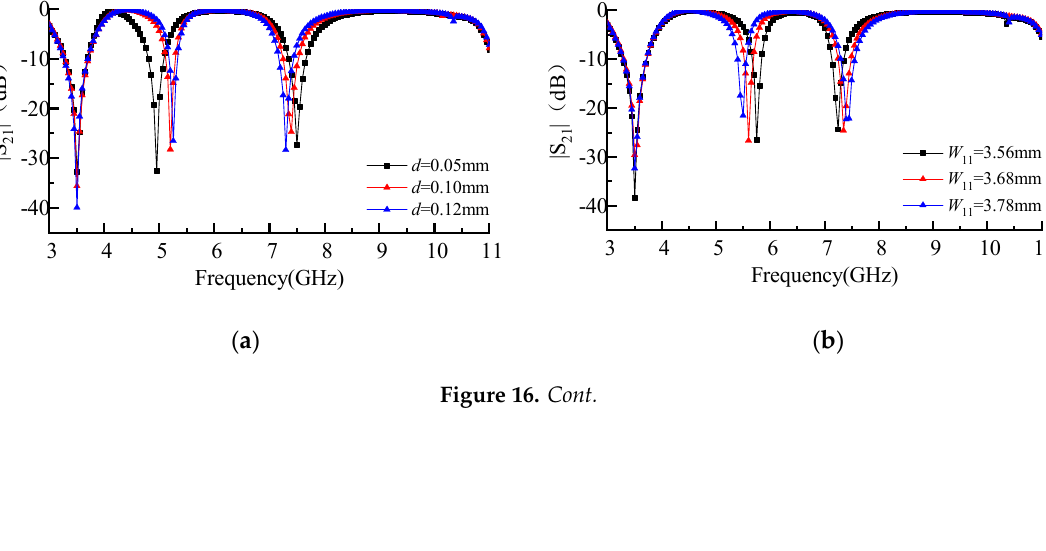
Figure 15. ( a ) Simulation results with different L 5 ( L 5 = 4.85 mm, f 1 = 3.87 GHz, L 5 = 5.21 mm, f 1 = 3.6 GHz, L 5 = 5.3 mm, f 1 = 3.51 GHz); ( b ) simulation results with different W 5 ( W 5 = 0.51 mm, f 1 = 3.47 GHz, W 5 = 0.51 mm, f 1 = 3.5 GHz, W 5 = 0.55 mm, f 1 = 3.54 GHz).